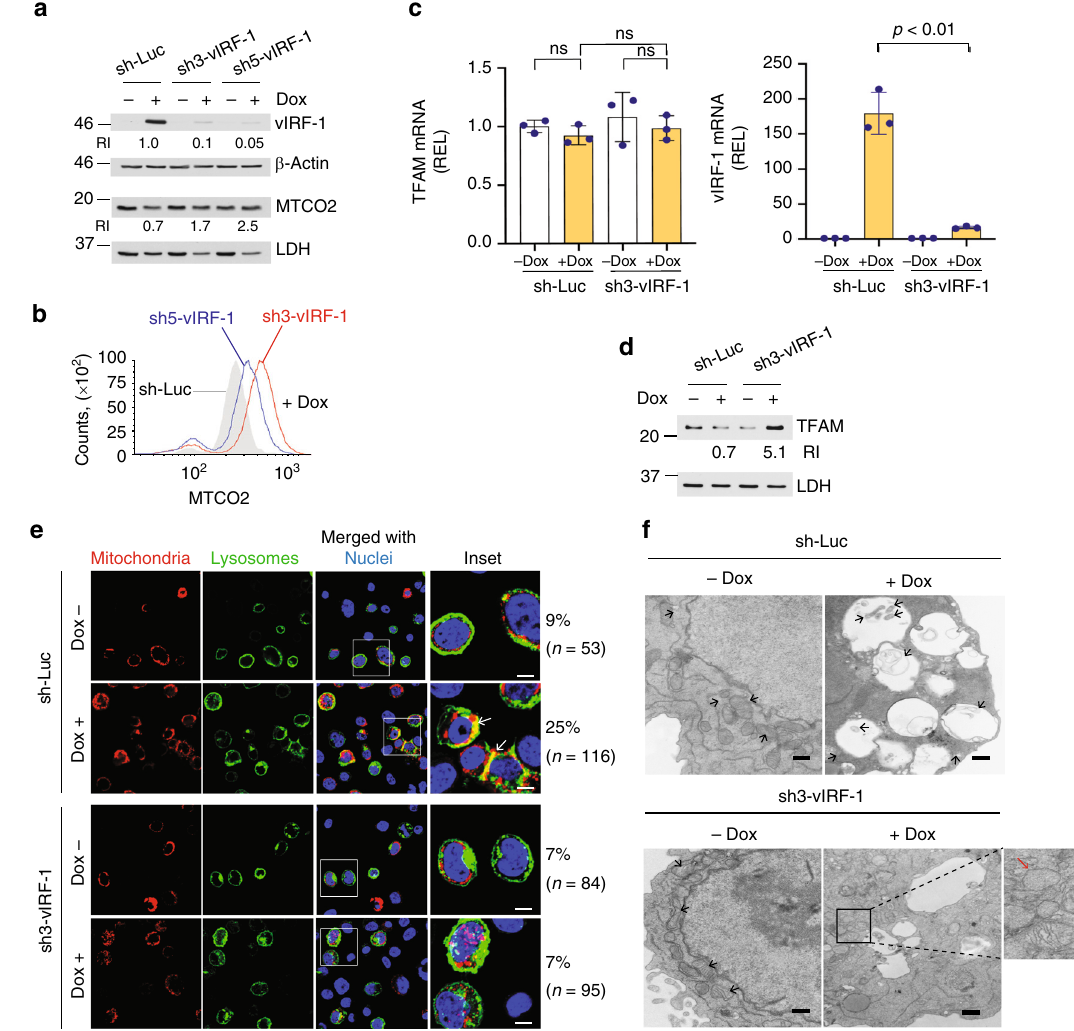
Fig. 2 vIRF-1 controls mitochondria content via mitophagy. a Immunoblot veri fi cations of vIRF-1 silencing by Dox-inducible shRNAs (sh3-vIRF-1 or sh5-vIRF-1). Luciferase shRNA (sh-Luc) was used as control. b Image cytometric analysis of MTCO2 expression in vIRF-1-depleted cells versus controls. c RT-qPCR analysis of TFAM and vIRF-1 mRNA expression. The relative expression levels (REL) were calculated using comparative Ct (2 - ΔΔ Ct ) method. Mean± SD, n = 3. ns, not signi fi cant. The p- value was determined by matched pair t -test. d Immunoblot analysis of TFAM protein. The RIs of TFAM are shown below each blot panel. e Assessment of mitolysosome formation using CellLight ® BacMam 2.0 system (see Methods for details). Representative images are presented, and the yellow areas (white arrows) indicate mitolysosomes. The percentages of mitolysosome-containing cells were determined among reporter- infected cells ( n ) and are noted on the side of the enlarged inset area. Scale bar, 5 µ m. f Electron microscopy images of the iBCBL-1 cells. Black and red arrows indicate mitochondria with normal and disrupted cristae, respectively. Scale bar, 500 nm. Source data are provided as a Source Data fi